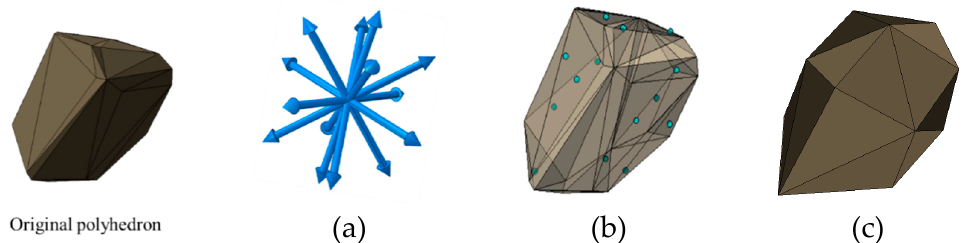
Figure 1. The simplified process of the polyhedron: ( a ) determine the pre-set vectors starting from the center of the polyhedron, ( b ) find the intersection points between the vectors and surfaces, ( c ) obtain the new surfaces of the polyhedron by determining the convex hull of intersection points.